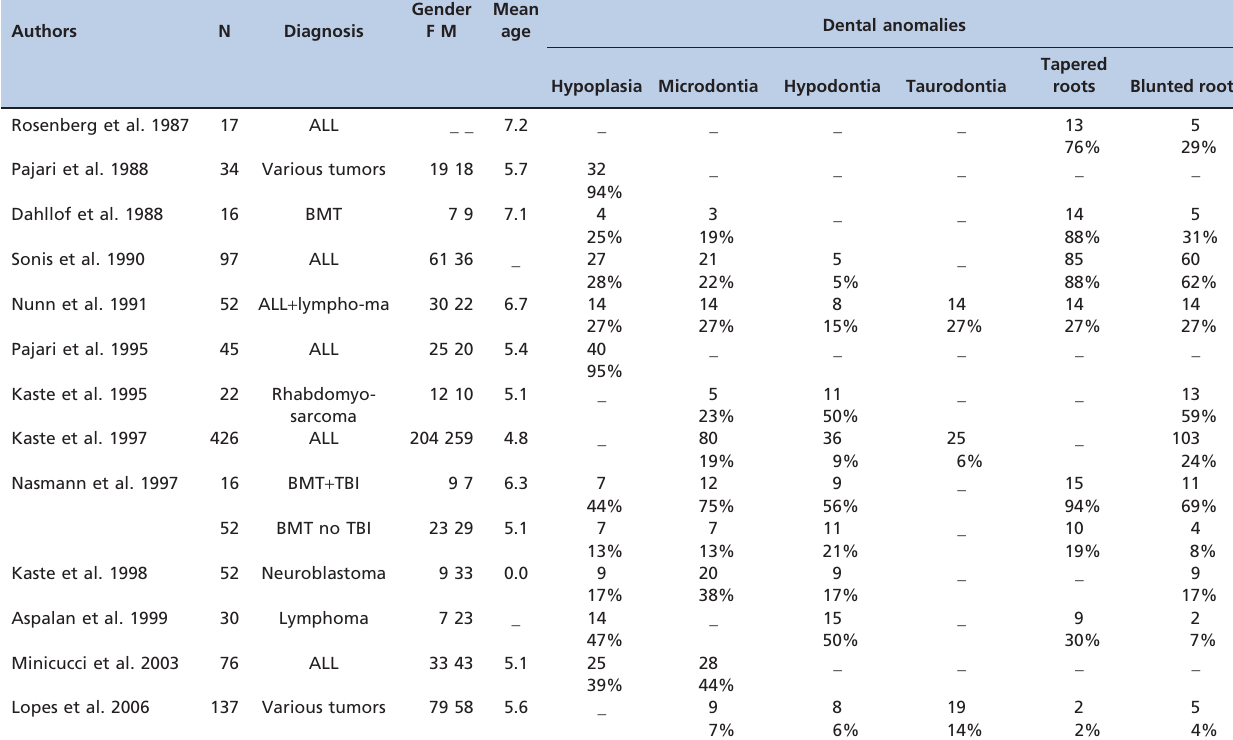
Table 1 - Prevalence of dental anomalies in childhood cancer